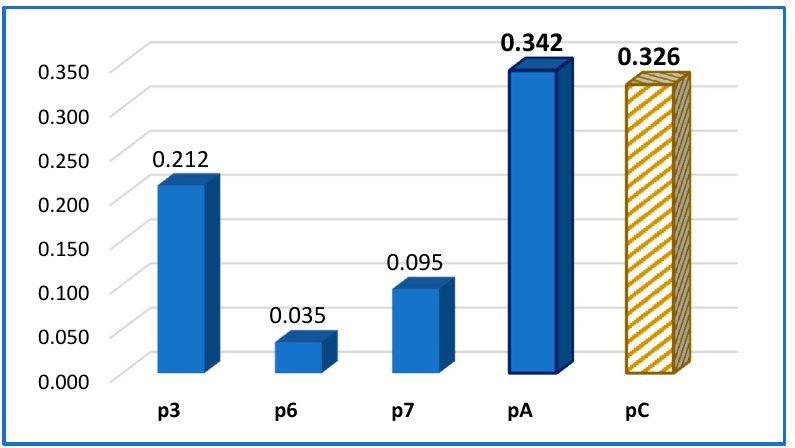
Figure 7. Equivalence of assessments before and after moving activities to the cloud (p A = p 3 + p 6 + p 7 for model “A”; p c for model “C”).